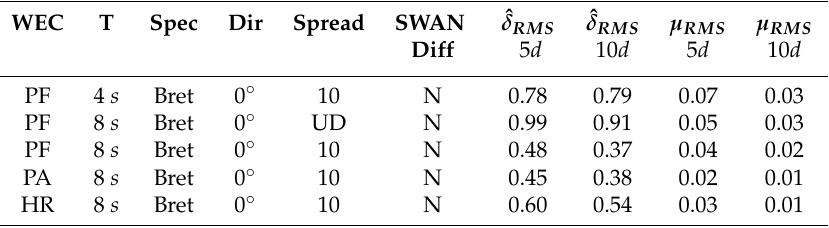
Table 5. Individual WEC results with the normalized root-mean-square (RMS) difference, ˆ δ RMS , and RMS wave field disturbance, µ RMS . The spread (or wave spreading, parameter is of the form, cos 2 s , where higher s values indicate a narrower directional